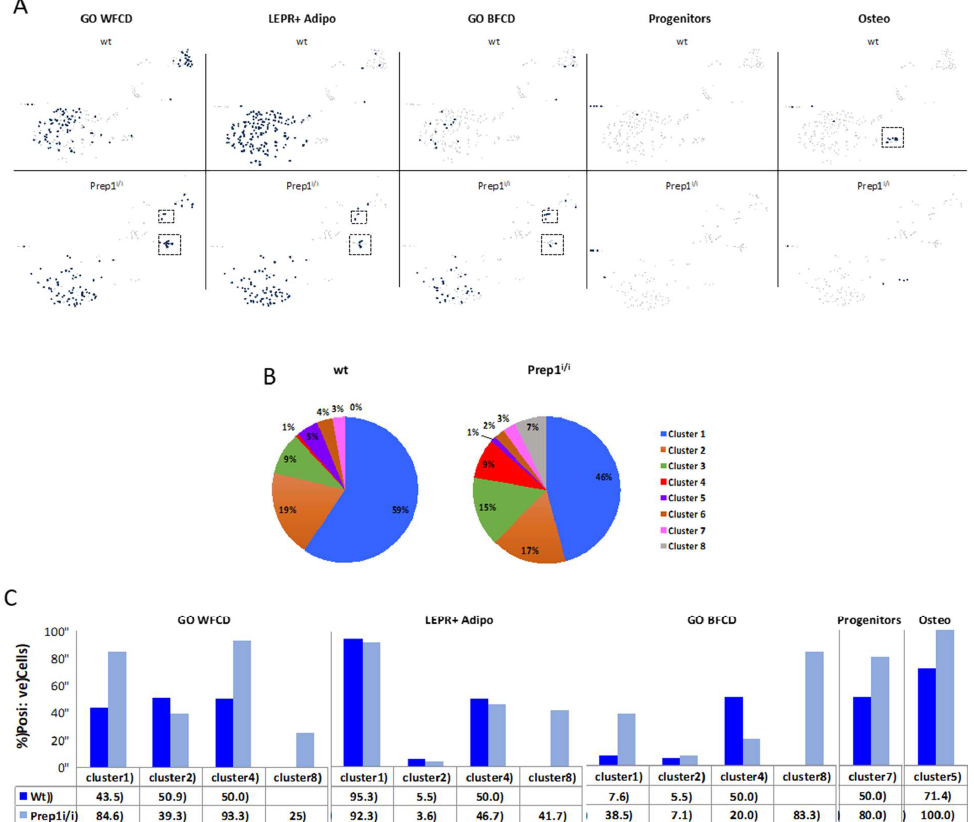
Figure 5. Cluster annotation highlights adipogenic and osteogenic subpopulations. ( A ) Annotation, using specific gene lists (GO White Fat Cell Differentiation, LEPR+ Adipo, GO Brown Fat Cell Differentiation, Progenitors and Osteo), shows the presence of specific cell types in each cluster. Dotted squares highlights clusters (most uniquely expressed per each genotype). ( B ) Pie charts depict percentages of cells present in each cluster. ( C ) Histograms show the percentage of cells per cluster which are positive to the indicated annotation. Blue bars indicate wt cells, light blue bars refer to hypomorphic cells. GO, Gene Ontology; WFCD, White Fat Cell Differentiation; LEPR, Leptin Receptor; BFCD, Brown Fat Cell Differentiation.